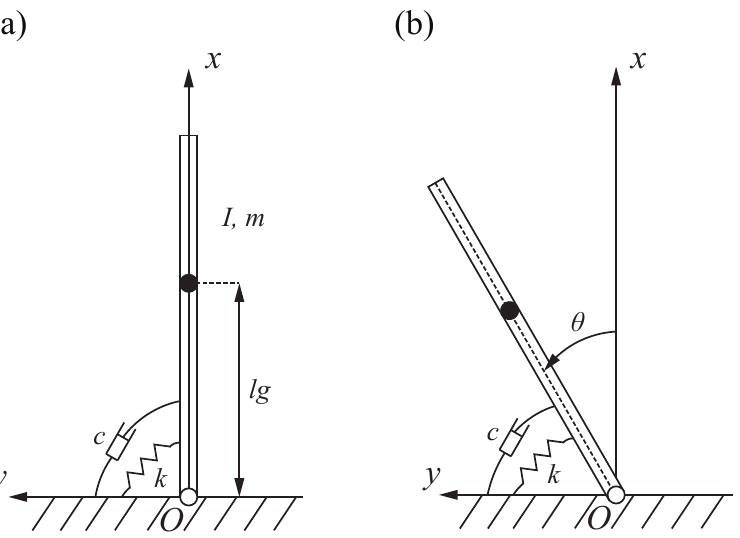
Figure A3. Model of inverted wiper blade. ( a ) Static inverted state. ( b ) Rotating